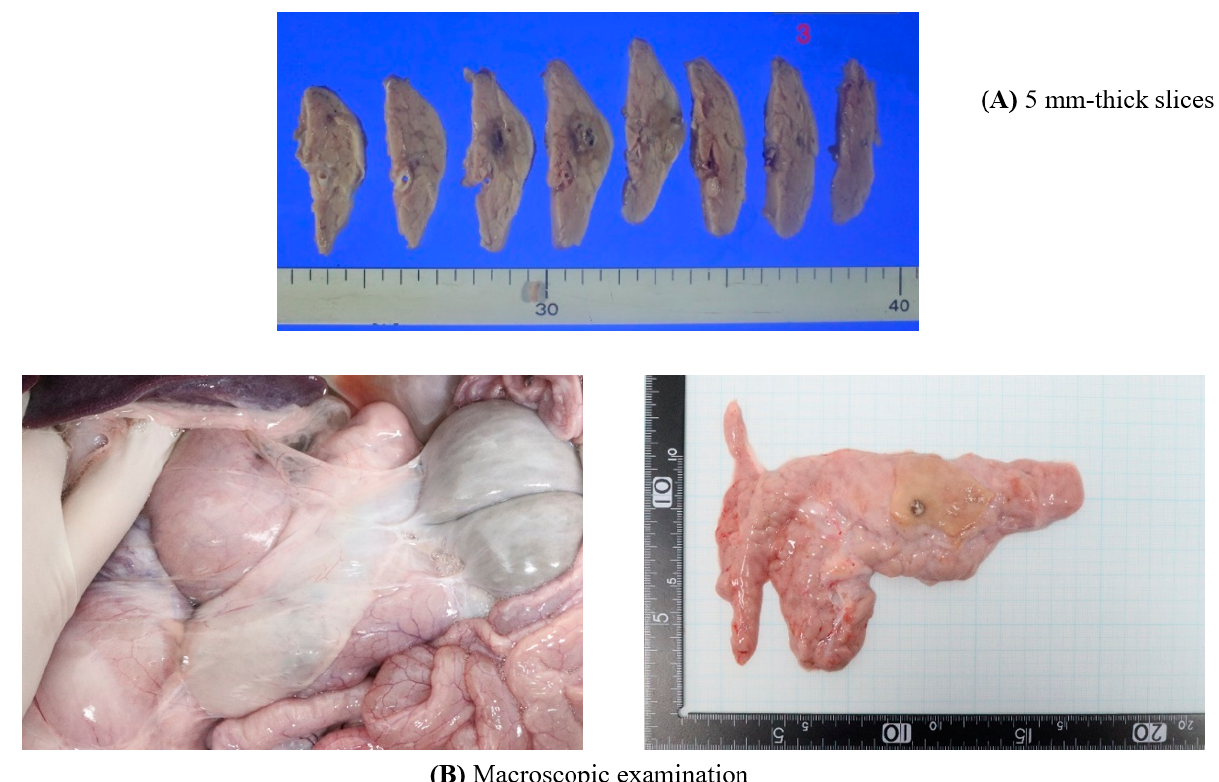
Figure 3 . Macroscopic examination Assessments of thermal ablation in in vivo pancreatic tissue 2 weeks after LA: macroscopic examination image revealed no gross abnormalities, such as perfora- tion, adhesion to adjacent structures, hematoma to surrounding organs in any of the five pigs. EUS-CILA ablated regions and untreated parenchyma were clearly differentiated in H&E-stained specimens (Figure 4). Mean ablated volume (cross-sectional area × length), as determined by histologic examination, was 55.5 mm 2 × 29.0 mm, and mean ablated areas in the pancreatic sections of the five pigs were not significantly different ( p = 0.368) (Figure 5).